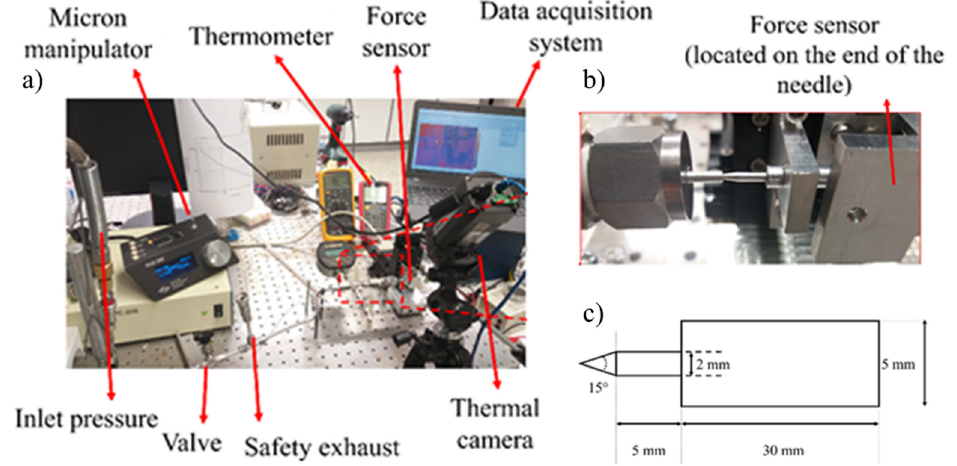
Figure 1. ( a ) Experimental setup and components: ( b ) test section; and ( c ) needle geometrical char- acteristics.